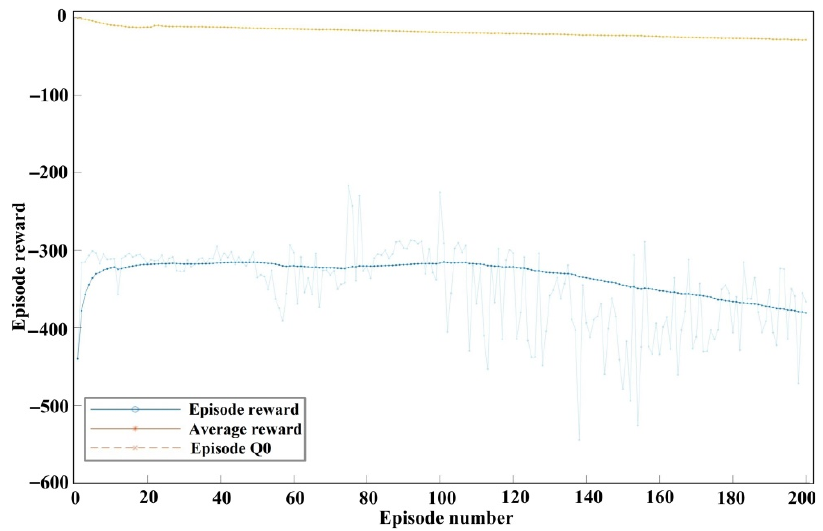
Figure 13. The training stage of the RL-TD3 agent for the correction of the u dref and u qref commands.